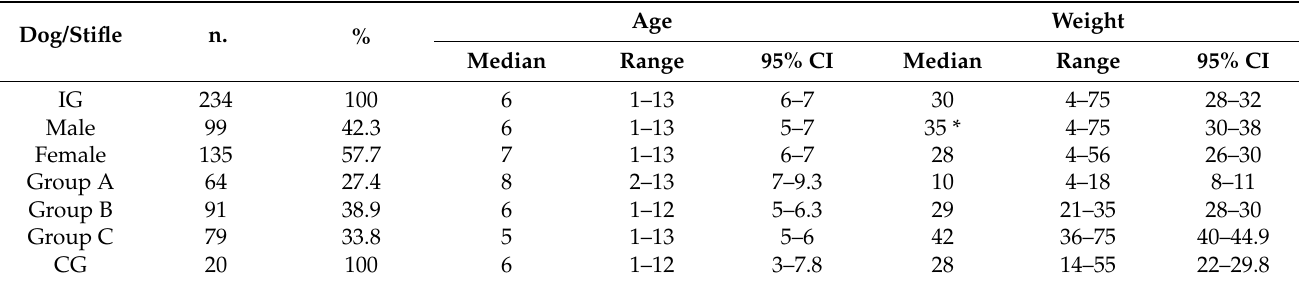
Table 1. Descriptive characteristics of the dogs. Median, range (minimum and maximum values) and 95% CI for the medians are reported for age (y) and weight